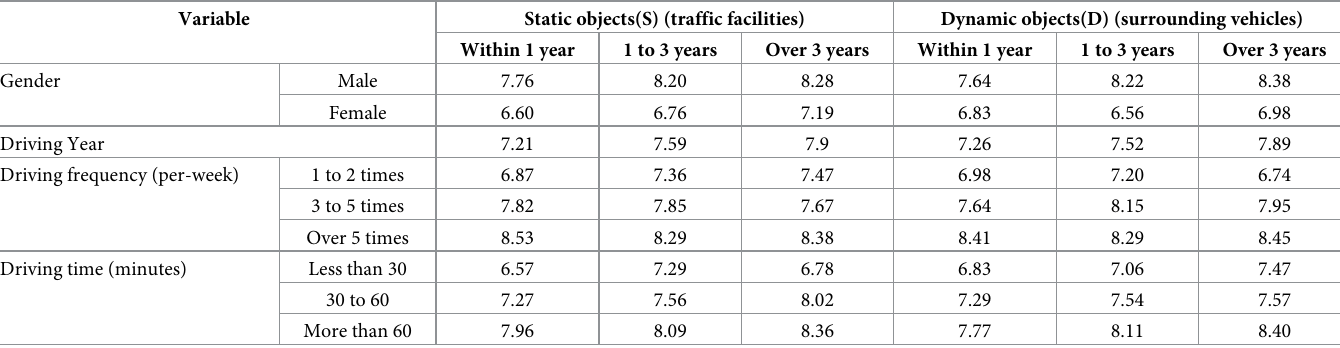
Table 2. Descriptive statistical of mean self-assessment score.